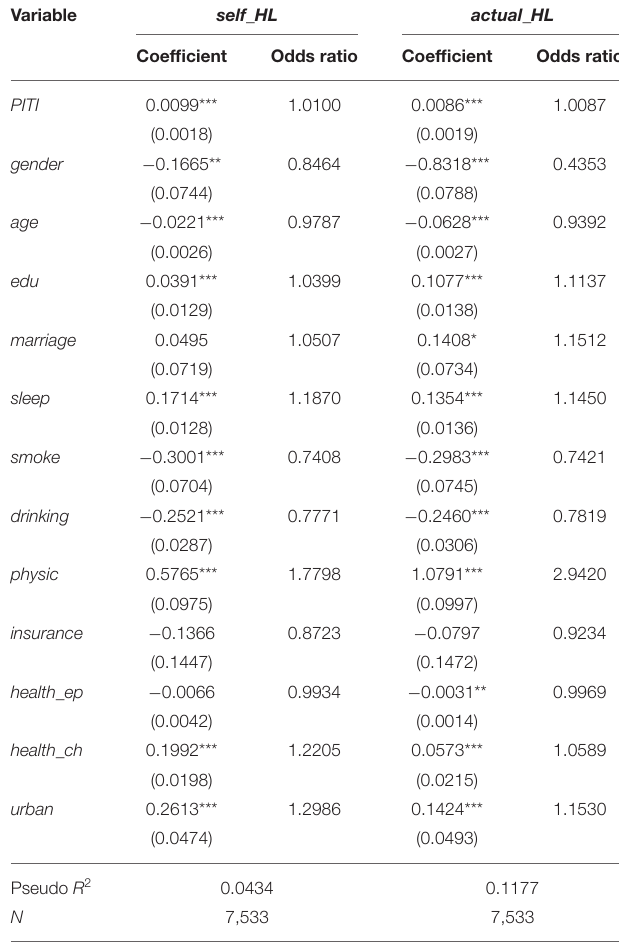
TABLE 6 | Benchmark regression